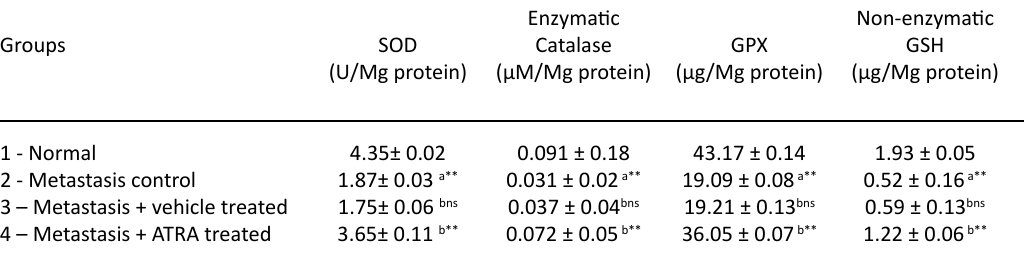
table 3. Levels of antioxidants in the lung tissue